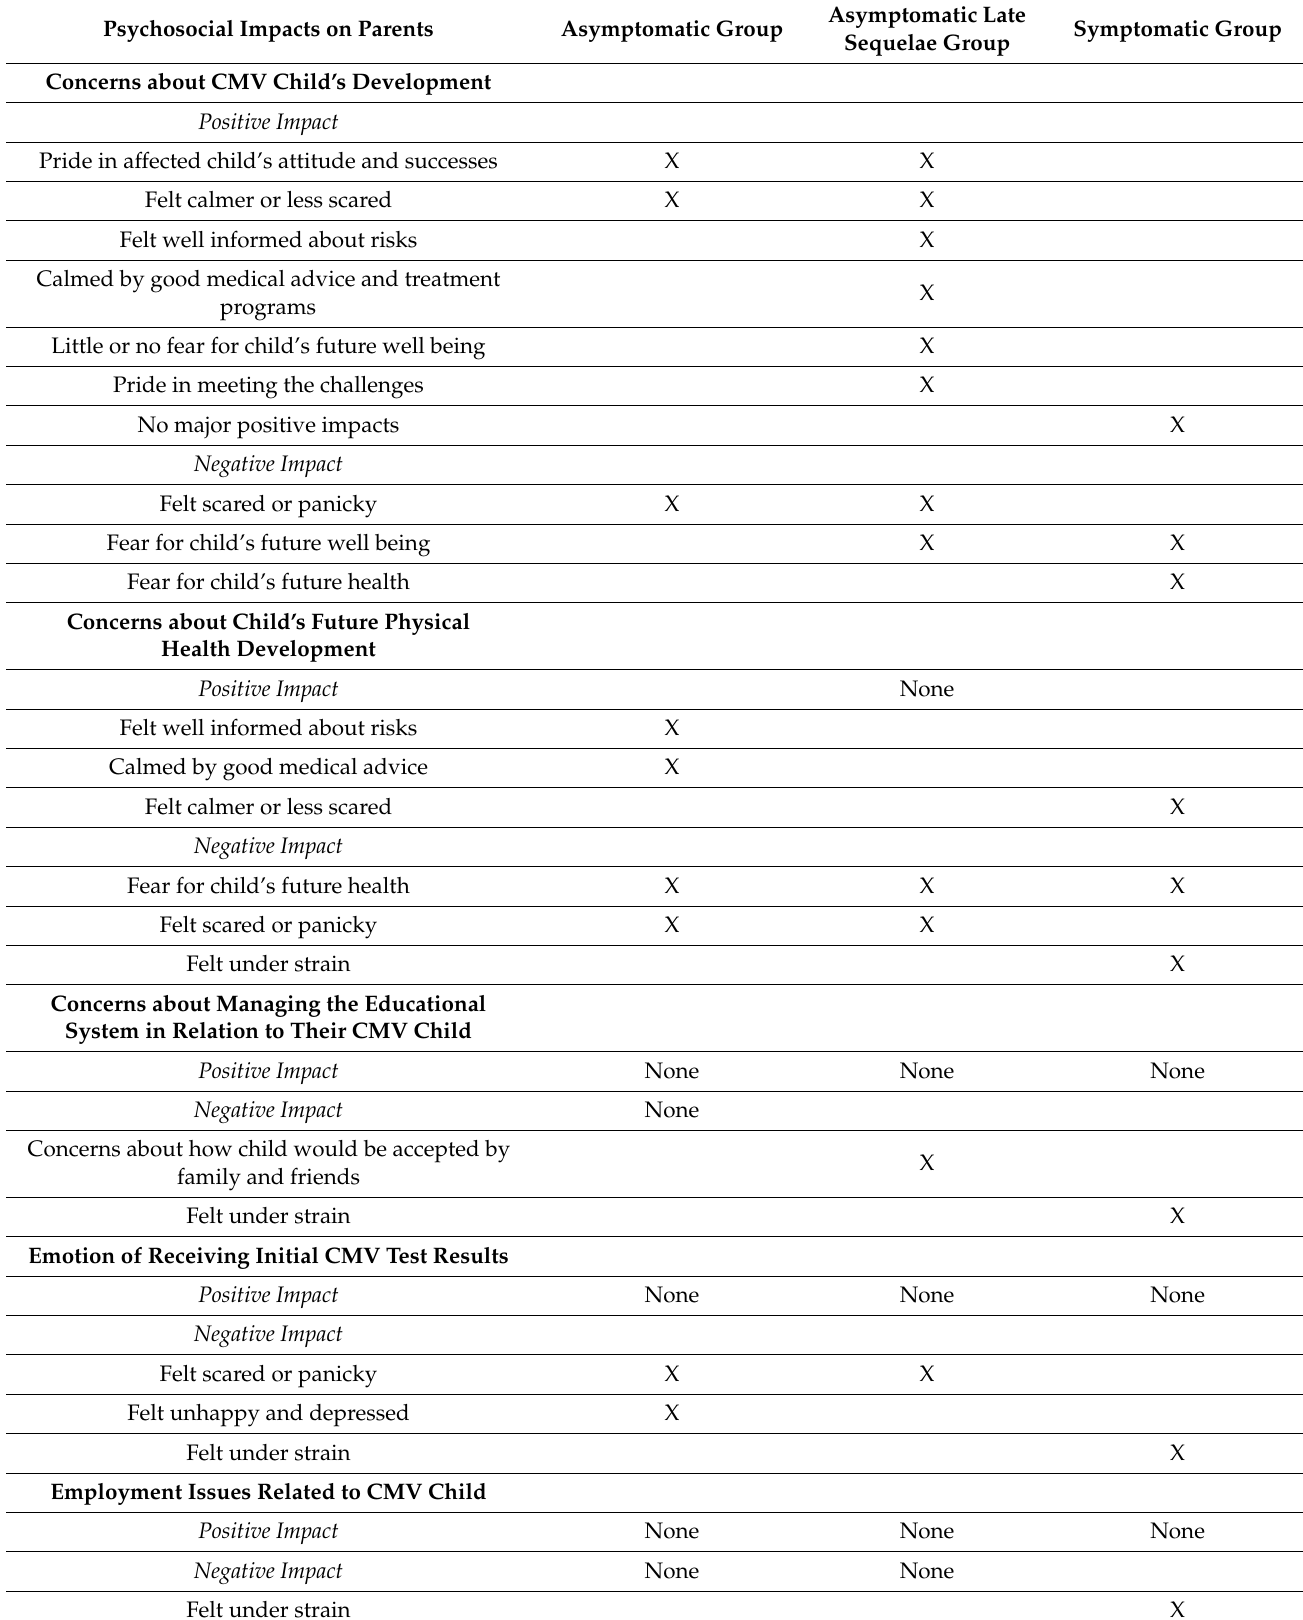
Table 3. Psychosocial Impacts on